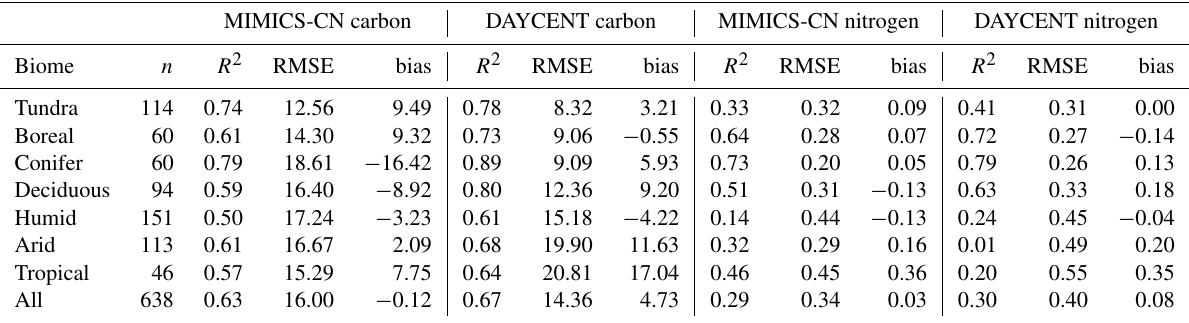
Table 2. Goodness-of-fit statistics comparing MIMICS-CN and DAYCENT simulations to observations of C and N in decomposing litterbags in the LIDET study, aggregated by biome. DAYCENT results are subset from simulations in Bonan et al. (2013) to match the sites included in MIMICS-CN simulations. The values shown are the number of observations ( n ), Pearson’s correlation coefficient squared ( R 2 ), root mean square error (RMSE), and bias calculated between observed and simulated percent C and N remaining. For more details on the sites grouped into each biome, see Wieder et al.